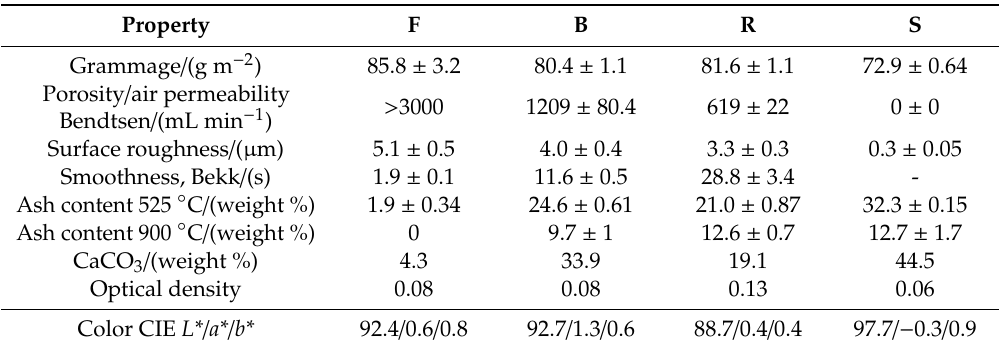
Table 2. Some physical and chemical properties of papers; F-filter paper, S-synthetic paper, B-bulky paper, R-recycled